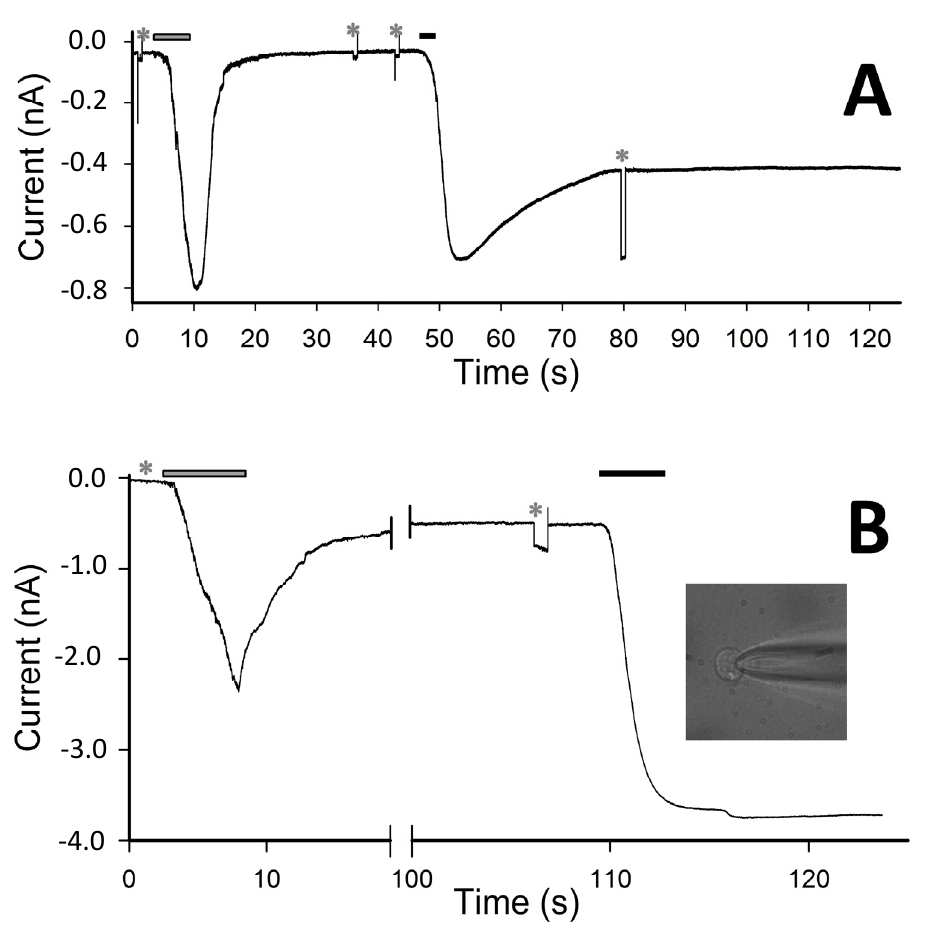
Figure 4. ( A ) Current elicited by the application (for 7 s) and withdrawal of 4 µM CM 18 -Tat (3 s, black bar) on the same cell. ( B ) Whole-cell current ( grey bar) and of 4 µM CM 18 11 recording elicited by the application and withdrawal of CM (9 s, 8 µM; grey bar) and of 18 CM -Tat (7 s, 8 µM, black bar) on the same cell; inset , lysis and death of cell following 18 11 -Tat . R in A and B was checked by means of >10 min application of CM 18 11 m − 10 mV pulses, indicated by the asterisks, i.e ., before CM application, after CM 18 18 withdrawal (and before CM -Tat application) and after CM -Tat application, 18 11 18 11 respectively, and found to be: 0.6 G Ω , 0.6 G Ω , 35 M Ω in A and 0.6 G Ω , 110 M Ω , and not measurable (too small) in B ; V = − 20 h